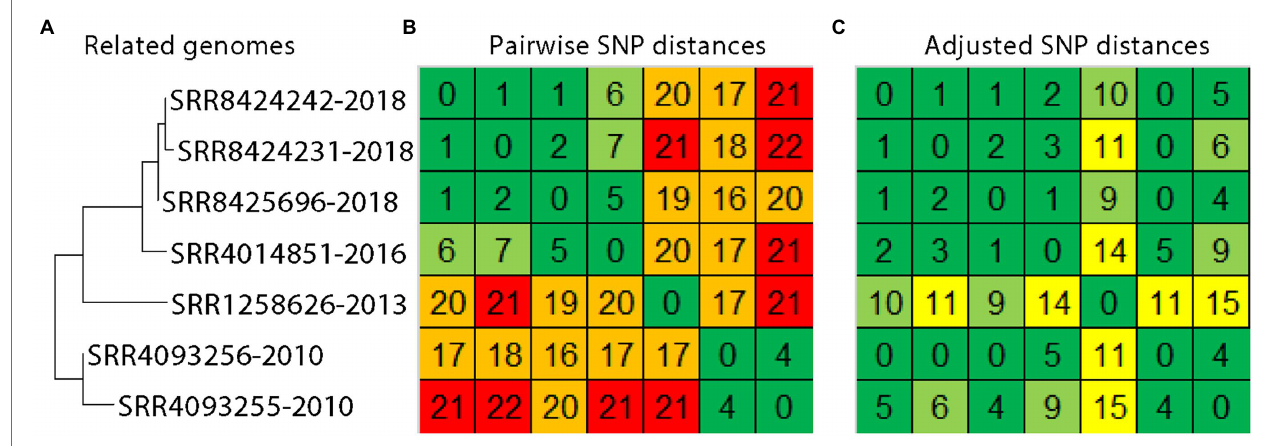
FIGURE 2 | Phylogenetic and pairwise SNP analysis of Salmonella enterica collected from the same facility over time. A phylogeny (A) and pairwise SNP distance matrix (B) was generated with the CFSAN SNP pipeline. Distances were adjusted manually to reflect the time spans separating collections at the rate of 1.97 SNPs/year (C)